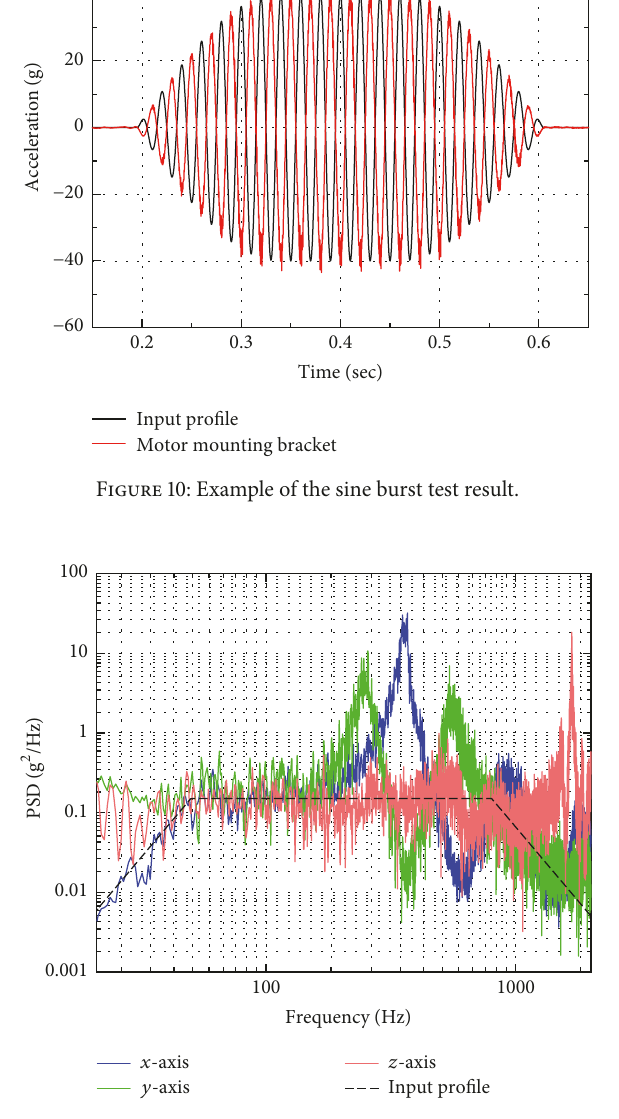
Figure 11: Example of the random vibration test result.